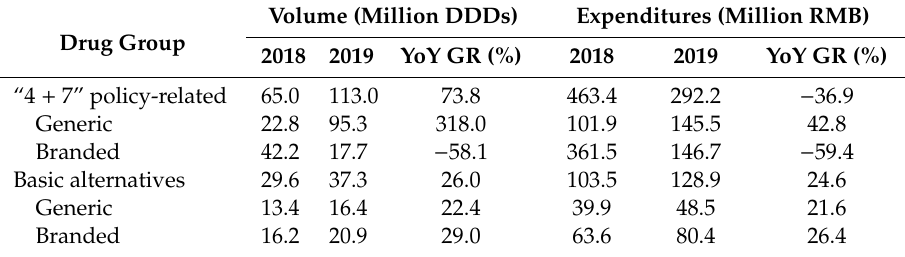
Table 2. Purchase volume, expenditures and their year-on-year growth rate (YoY CR) of generic and